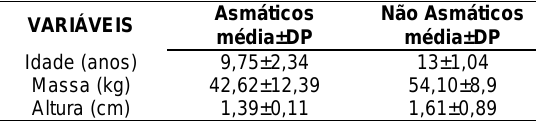
Tabela 1. Análise descritiva dos